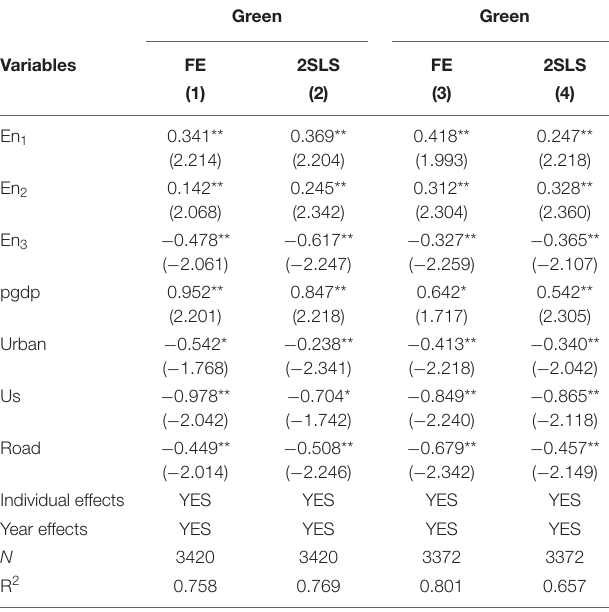
TABLE 4 | Regression results of robustness tests. TABLE 5 | Examining the mechanisms by which environmental regulation affects urban green